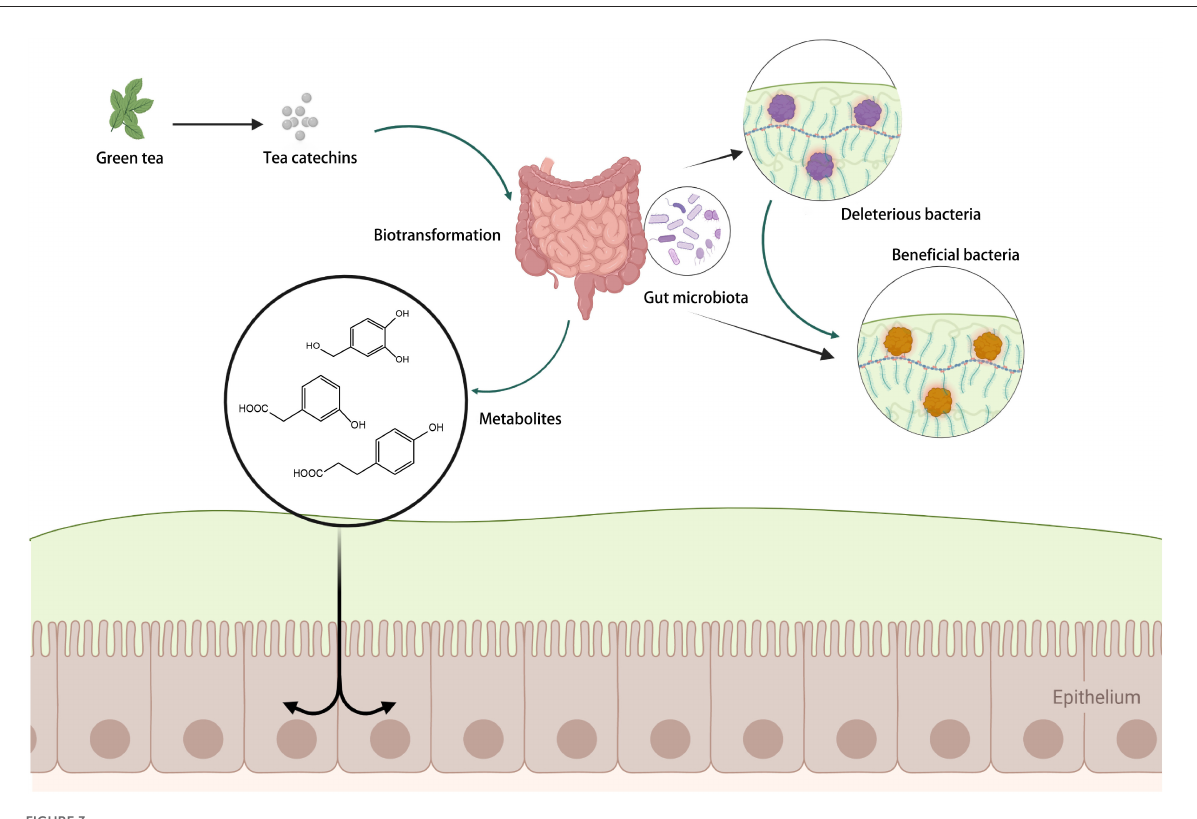
FIGURE3 The regulation of catechins on gut microbiota. Created with